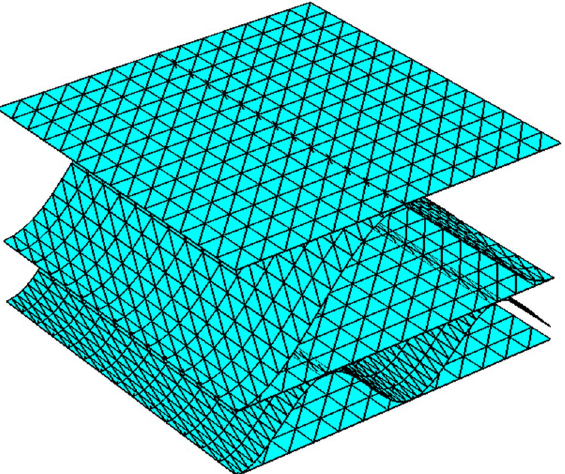
Figure 18. Visualization of the finite element model of corrugated board BE-650.